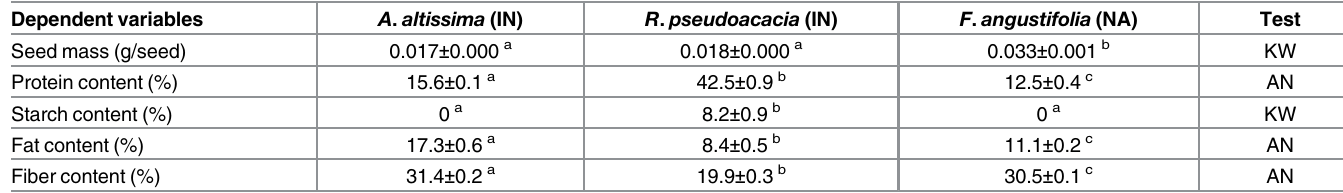
(IN) = invasive; (NA) = native Bonferroni correction ( P < 0.02).